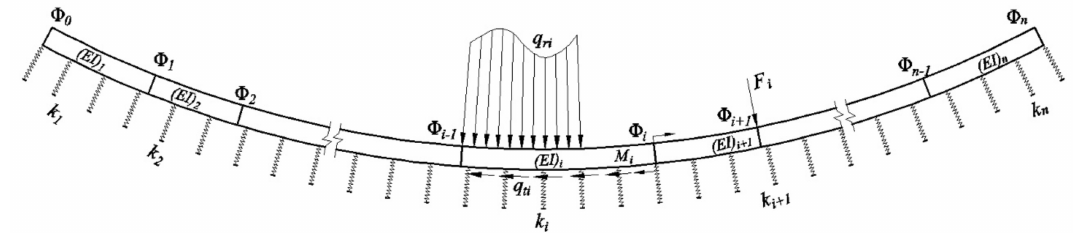
Figure 6. Sectional schematic diagram of the circular curved beam.